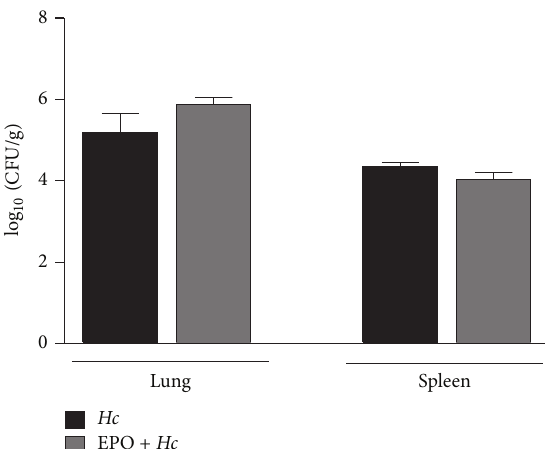
Figure 2: EPO pretreatment did not alter fungal burden in the lungs and spleen of Hc -infected mice. Hc and EPO + Hc animals were infected i.t. with sublethal (5 × 10 5 yeasts/100 𝜇 L/mouse) inoculum and fungal burden determined in lungs and spleen 14 days later. Fungal burden was expressed as log 10 of the number of colony-forming units per gram of tissue (CFU/g). Mean ± SEM values are from one representative of two independent experiments ( 𝑛 = 4 –6). Non differences were determined using Newman-Keuls multiple comparison test.